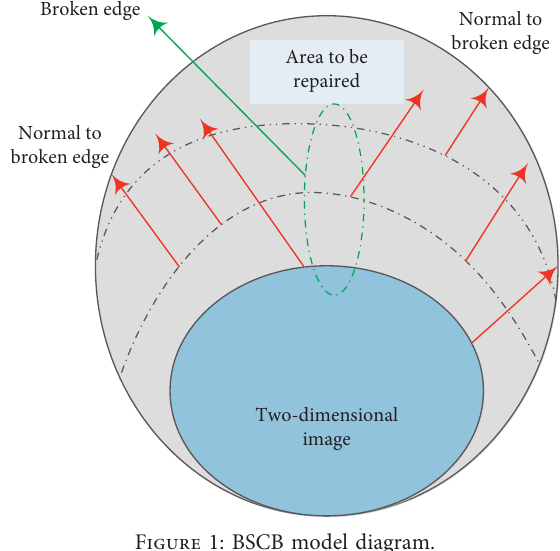
Figure 1: BSCB model diagram.